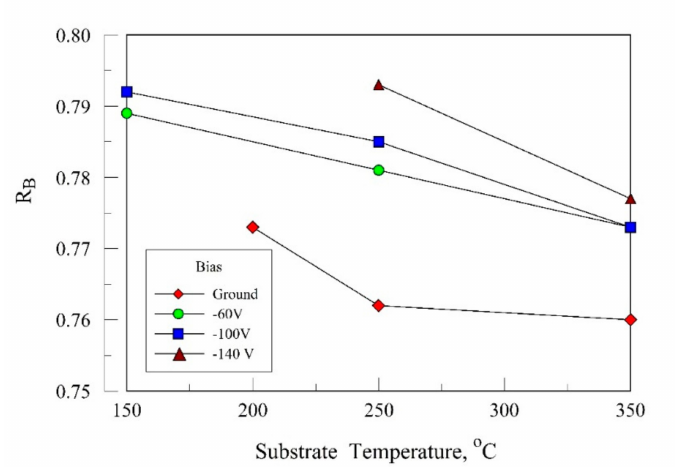
Figure 4. Measured values of R B for films deposited at various bias levels and substrate temperatures. The values of R B generally decrease with temperature and increase with substrate bias.